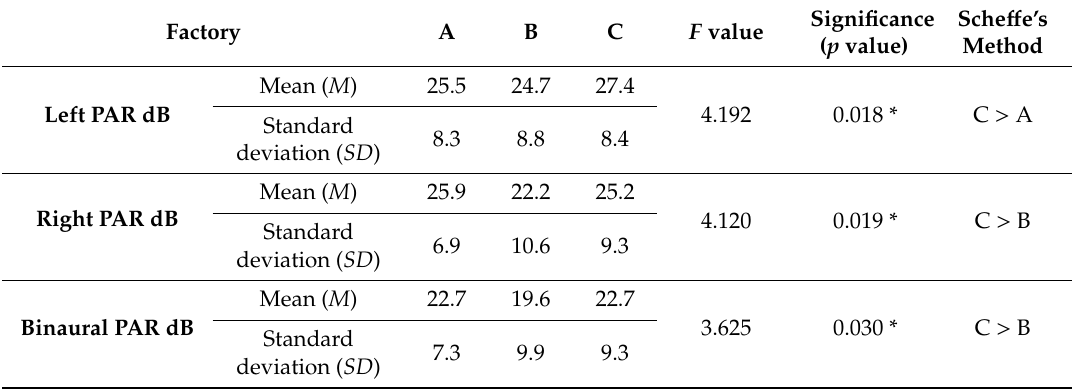
Table 5. Relevant results of statistical analysis and tests of the PAR values from the three participating factories in this